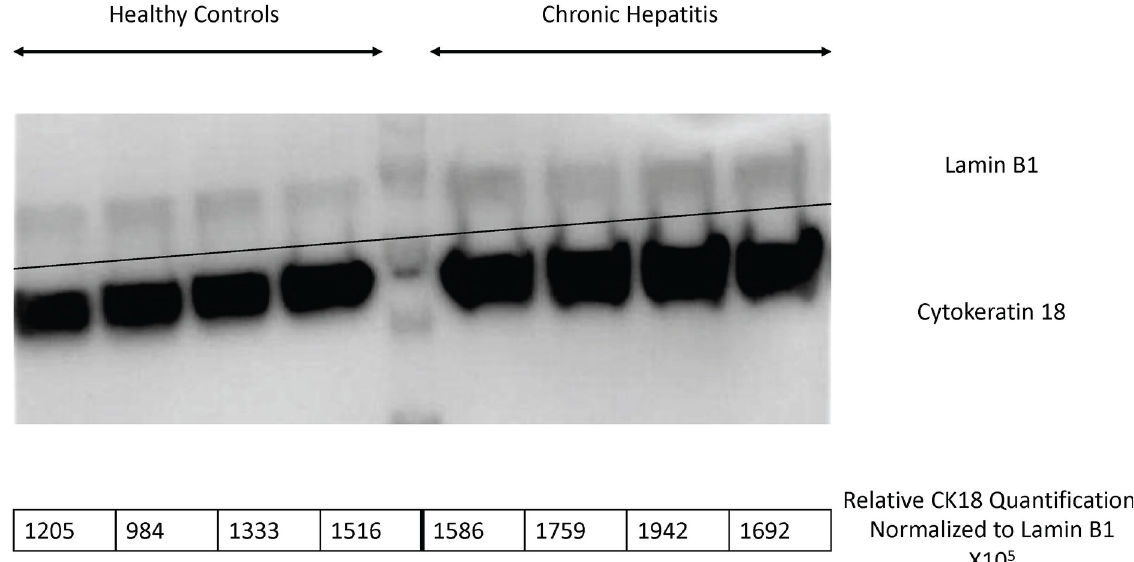
Fig 3. Abundance of cytokeratin 18 in the hepatic tissue of dogs with chronic hepatitis by Western blot analysis. Cytokeratin 18 was assessed in the liver proteome of 4 dogs with chronic hepatitis and compared to 4 healthy control dogs. Lamin was used as a loading control.